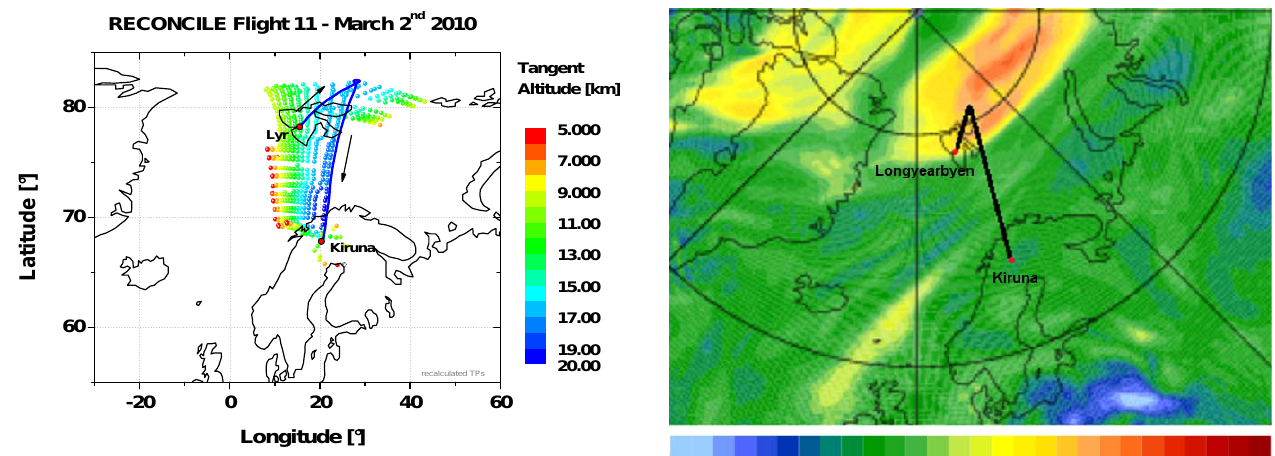
Fig. 7. Flight track of the Geophyscia for RECONCILE flight 11 (solid blue line) and distribution of tangent points of the MIPAS- STR observations, colour-coded with reference to the tangent altitude.